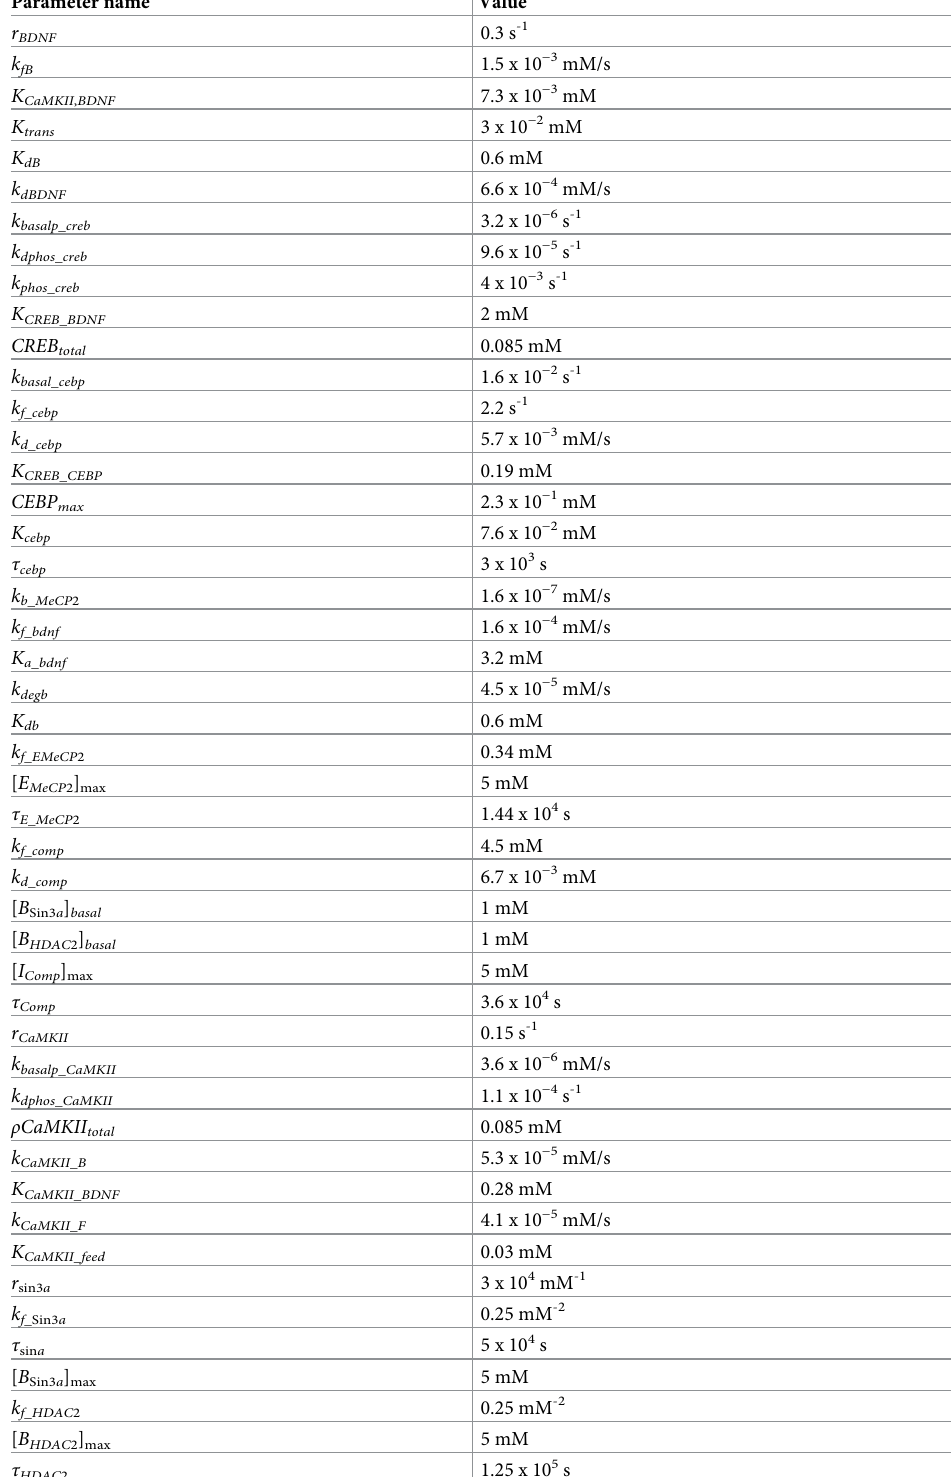
Table 1. Standard parameter